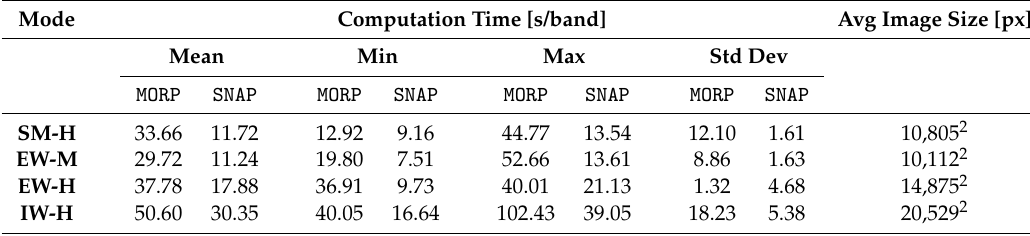
Table 3. Performance assessment of the proposed method ( MORP ) in comparison with SNAP’s ‘Remove GRD Border Noise’ module ( SNAP ): mean, minimum, maximum, and standard deviation of the computation time required to process a single image band. The results are disaggregated by mode and